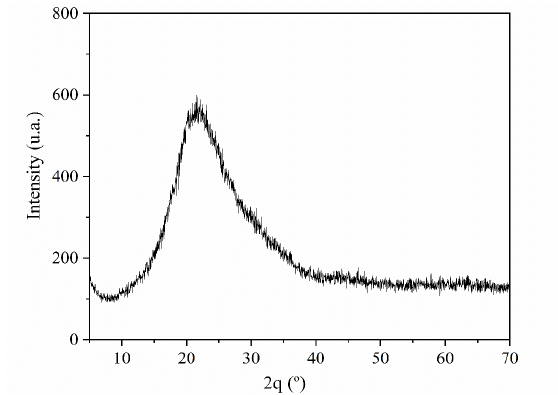
Figure 1. X-ray diffractogram of NS.